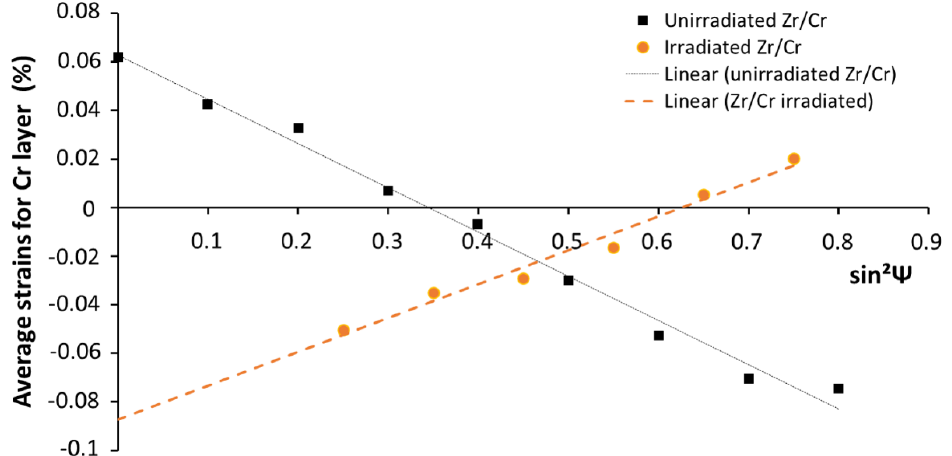
Figure 7. Average strains for Cr layer versus sin 2 Ψ curves for unirradiated (black boxes) and irradiated (orange circles) samples. Dotted lines symbolize the linear regression for the sin 2 Ψ method.